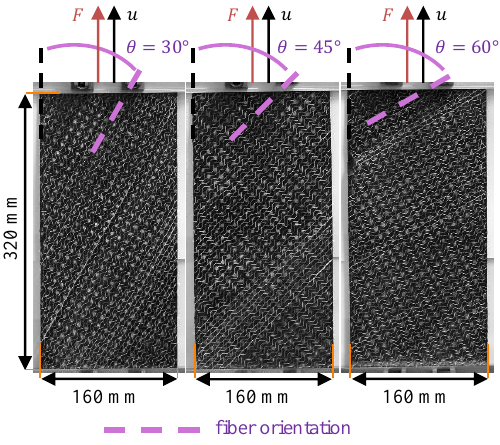
Figure 6. Definition of the fiber orientation for off-axis tension